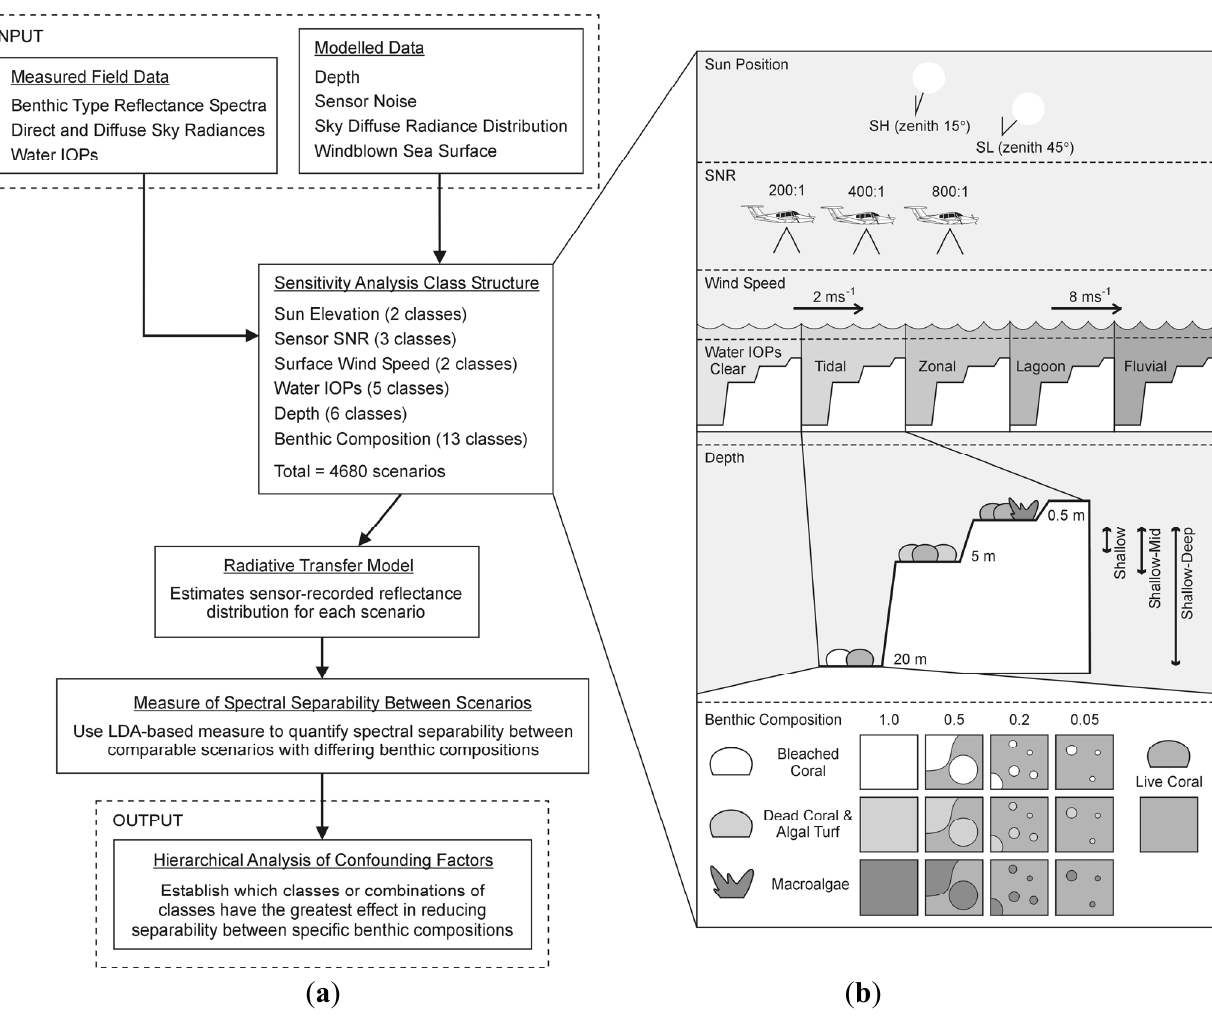
Figure 3. Methods flowchart ( a ) and sensitivity analysis structure ( b ). Each combination of benthic type, environmental component and sensor SNR treatment corresponds to a single model scenario. For each scenario the representative distribution of total remote sensing reflectance, R , is estimated by radiative transfer modelling. The separabilities between t scenarios with differing benthic types and identical environmental and sensor treatments are estimated in spectral space. The hierarchical analysis reveals which sensor and environmental treatments have the greatest effect in reducing benthic type